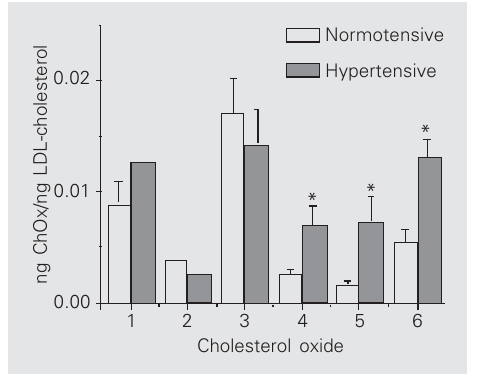
Figure 2. Cholesterol oxides (ChOx) in LDL of normotensive subjects and essential hyper- tensive patients. 1 , 7 (cid:1) -OH,